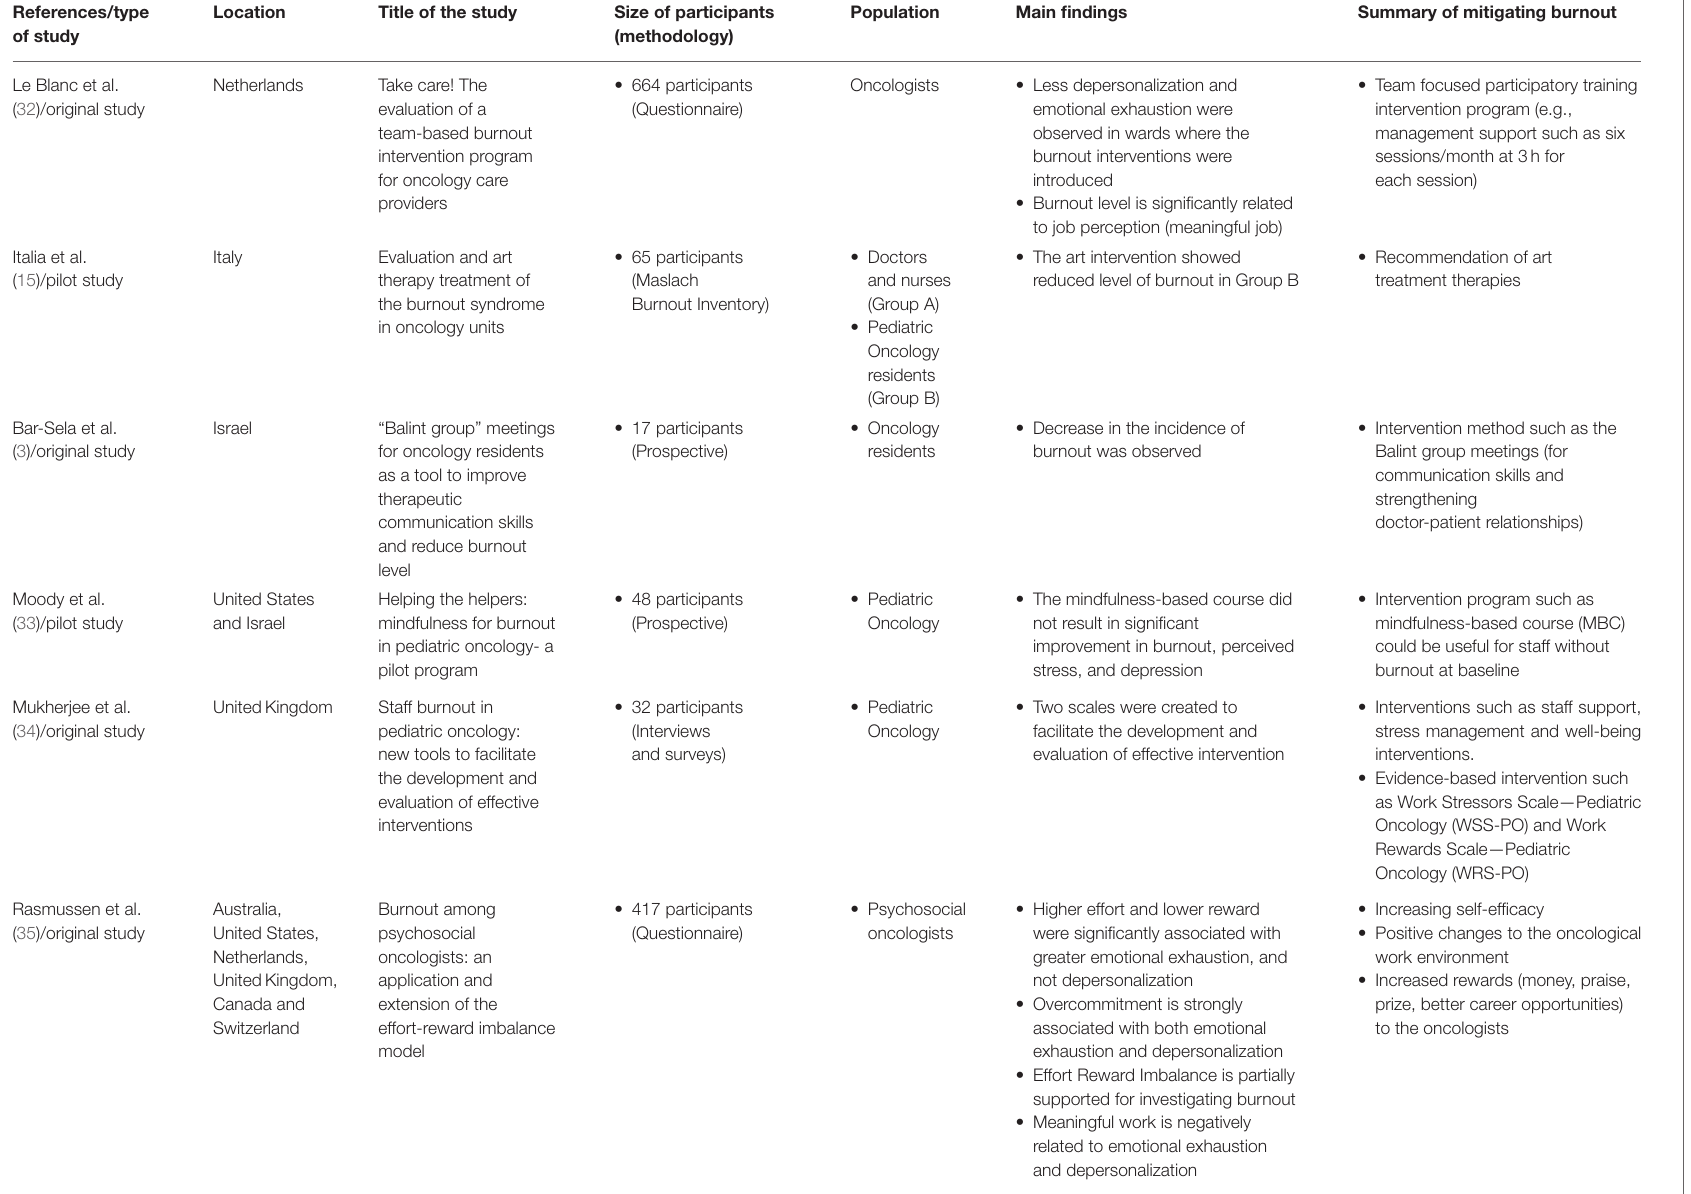
TABLE 1 | The main findings from the included